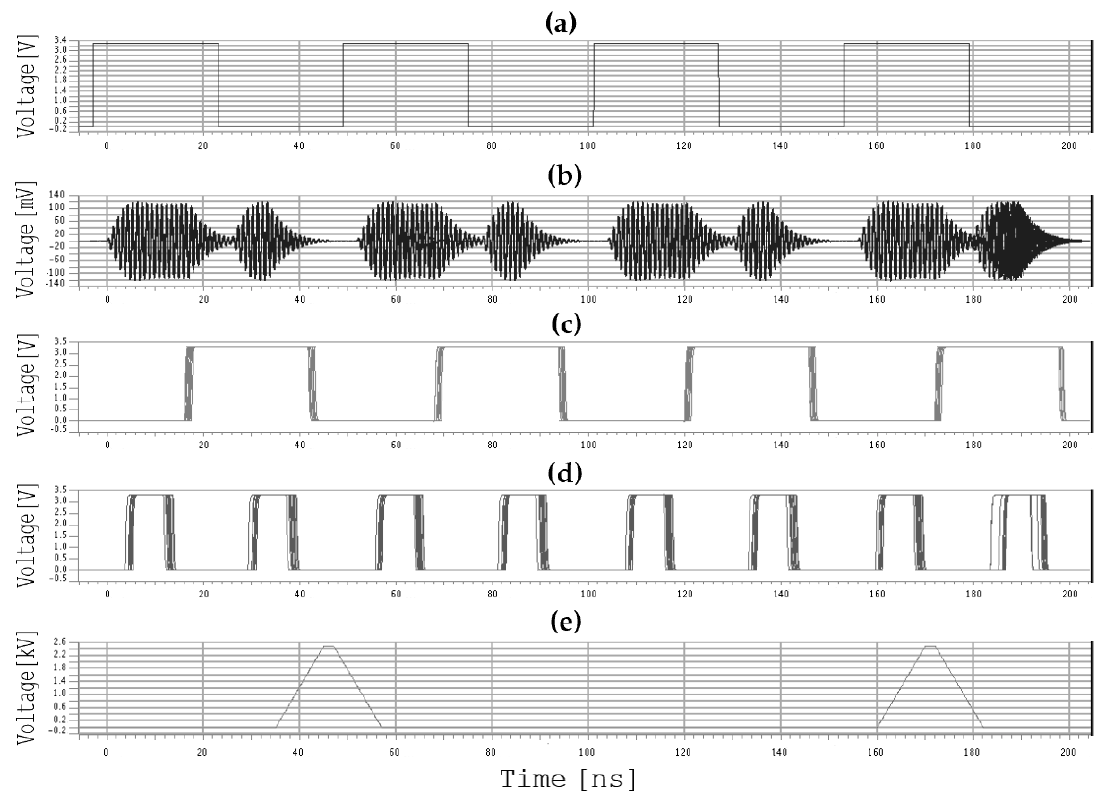
Figure 19. Isolated data link simulations in the presence of a 250-kV / µ s common mode (CM) disturbance ( f D = 40 Mb / s, Montecarlo (MC) runs = 200, σ = 4). ( a ) D IN ; ( b ) RX antenna voltage; ( c ) D OUT ; ( d ) CK OUT ; ( e ) common mode transients (CMTs).